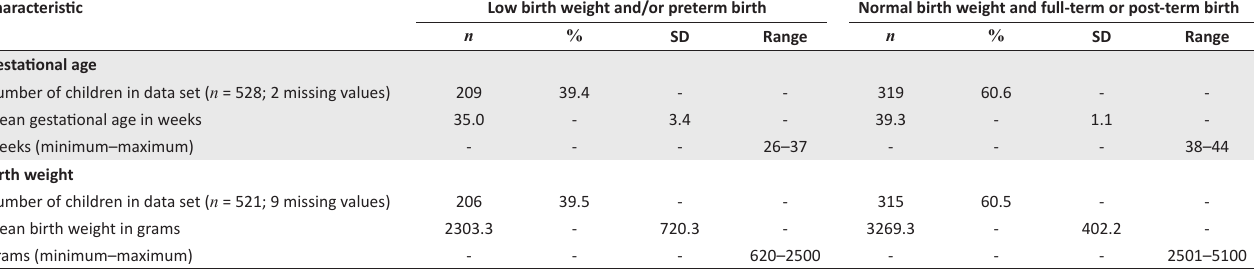
TABLE 2: Frequency of low birth weight and preterm birth. Characteristic